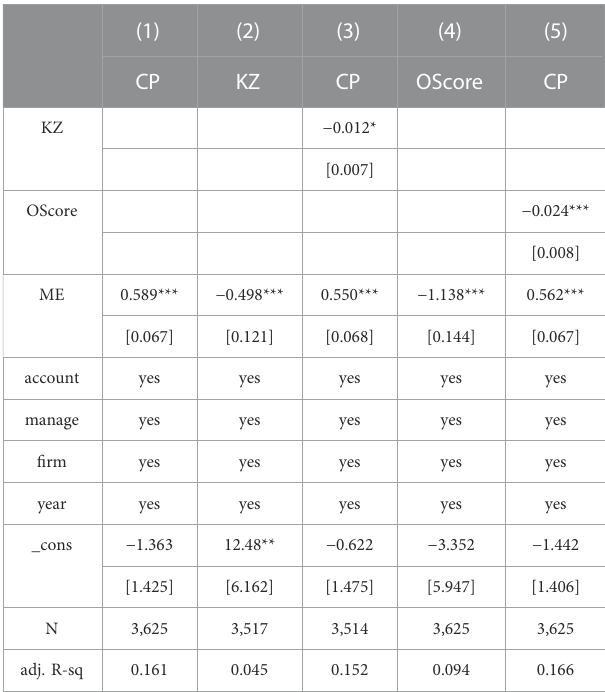
The test results for robustness are displayed in column 2 of Table 6.